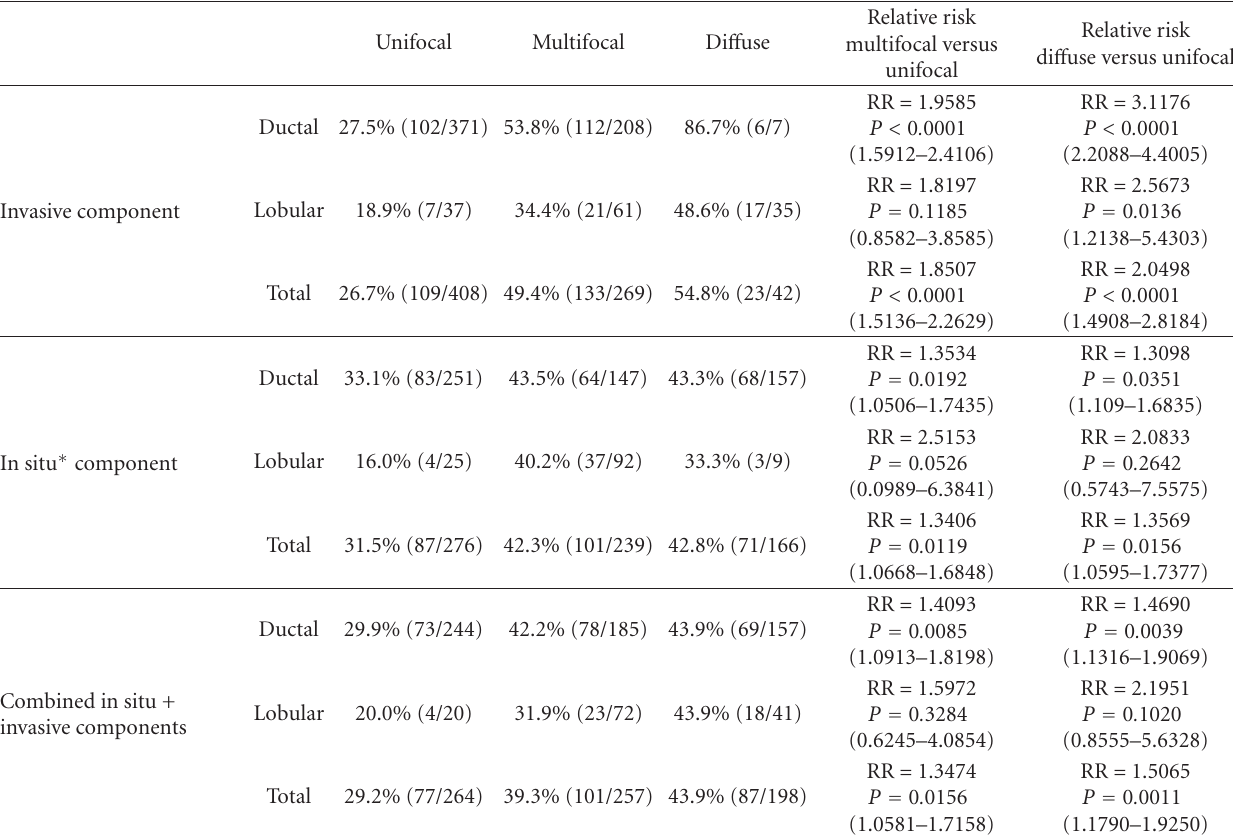
Table 3: Relative risk of having lymph node metastasis in ductal and lobular breast carcinomas by lesion distribution, Dalarna, Jan 2008–Jul